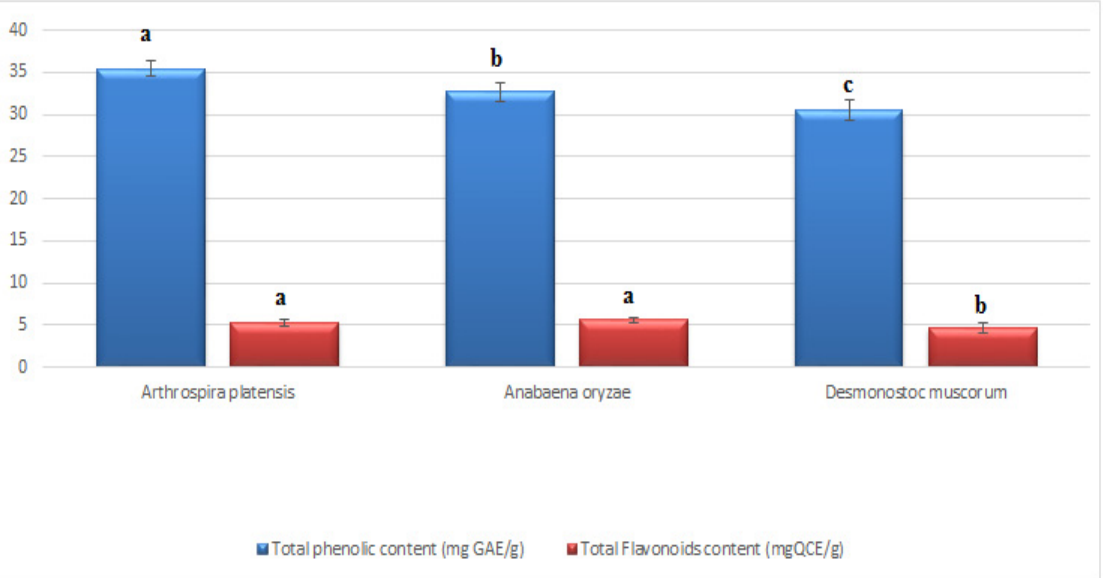
Figure 1. Variation in the total phenolics and flavonoid content of different applied cyanobacteria in the soil application and foliar spraying. Data represent mean ± SD, n = 3. (a–c Letters revered to significant in statically analysis).